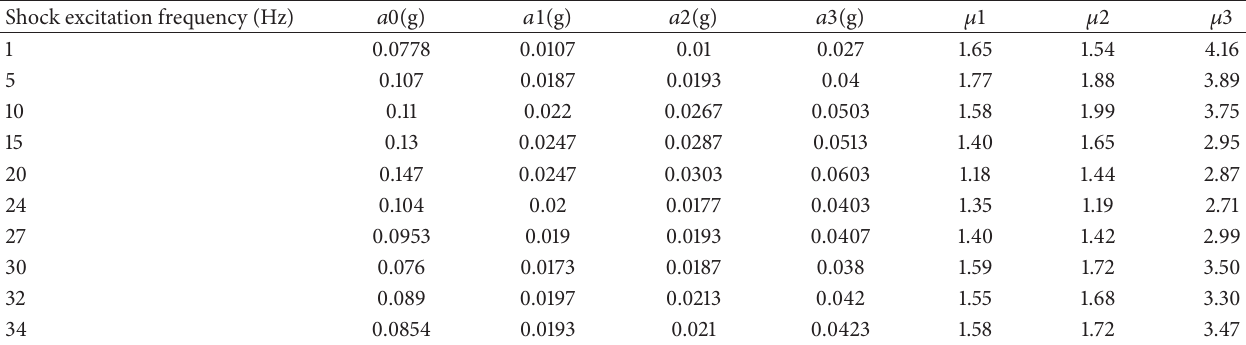
Table 8: Extreme and enhancement coefficient of acceleration response